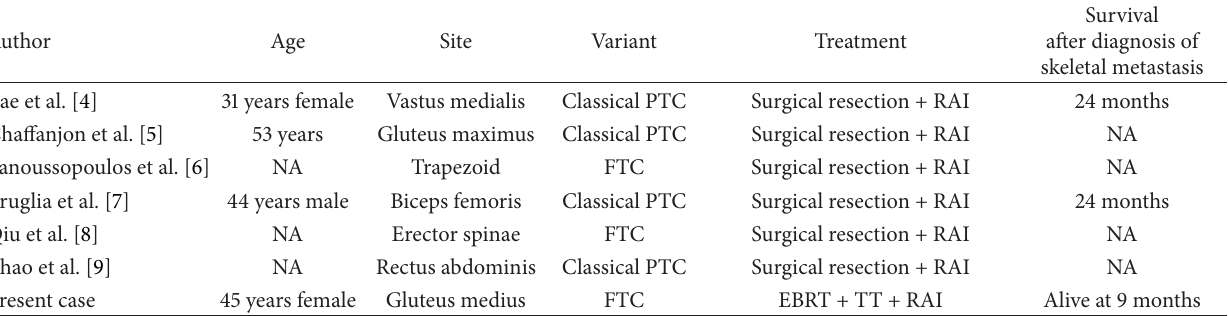
Figure 3: Palliative radiotherapy 30 Gy in 10 fractions to the right gluteal mass using posteroanterior (PA) and right lateral beams. Table 1: Cases of skeletal muscle metastasis secondary to thyroid carcinoma reported from